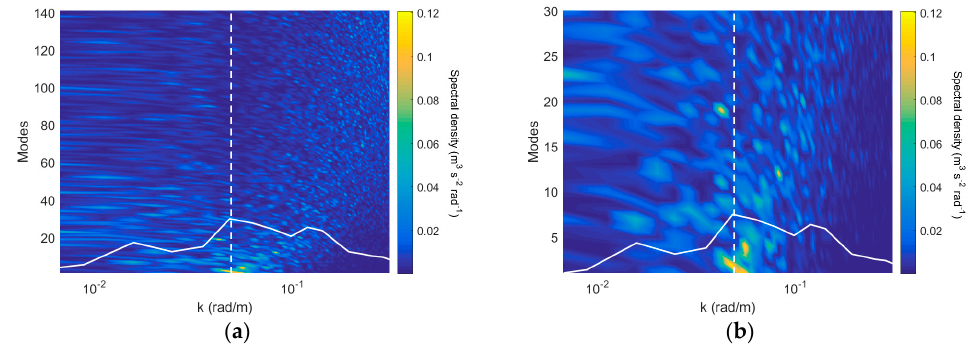
Figure 4. 1D wavenumber spectra of individual mode velocity reconstructions versus mode number for the UM radar (dataset 14). Panel ( a ) shows the full range of proper orthogonal decomposition (POD) modes and panel ( b ) shows a zoom-in of the leading 30 modes. The solid white line is the corresponding average spectrum of all the buoys amplified by 2000 for ( a ) and by 500 for ( b ) for visibility. The white dashed line denotes the peak wavelength.